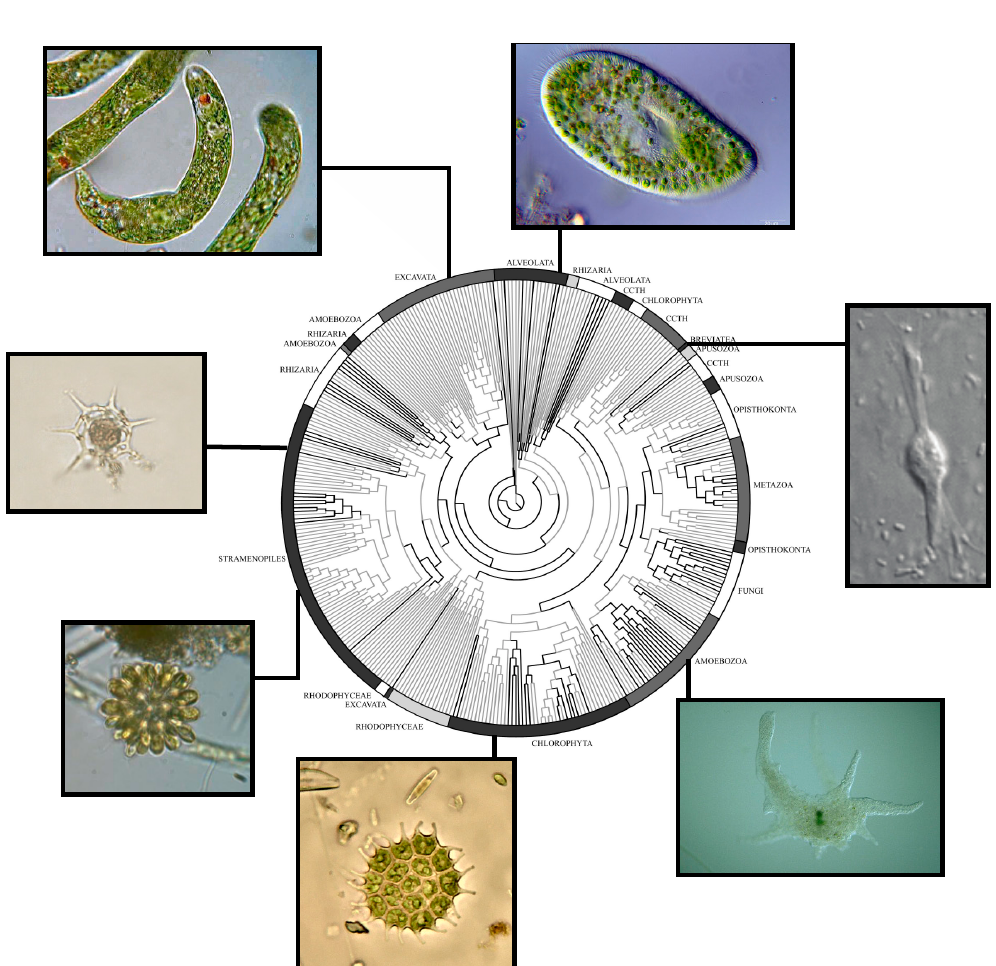
Figure 3. Diversity of eukaryotes identified in oil sands tailings ponds. Tree is derived from pplacer, with a universal backbone of eukaryotes based on the 18S rRNA ribosomal gene (modified with permission from Aguilar et al. [48]). Microscopy image of Breviatea derived (with permission) from Walker et al. [49]. Other Microscope images are reproduced under Creative Commons licenses from the following authors (clockwise from top left): Deuterostome; Anatoly Mikhaltsov; Tsukii Yuji; U.S. Environmental Protection Agency; Deuterostome; Minami